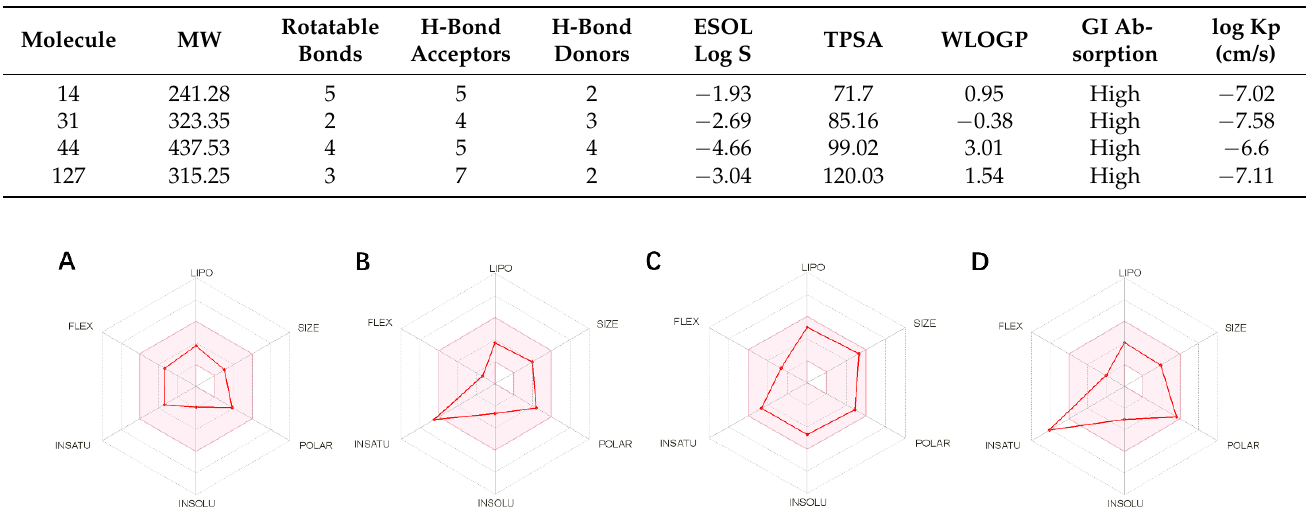
Table 4. ADME properties of ligands selected from the Marine Natural Products Library.